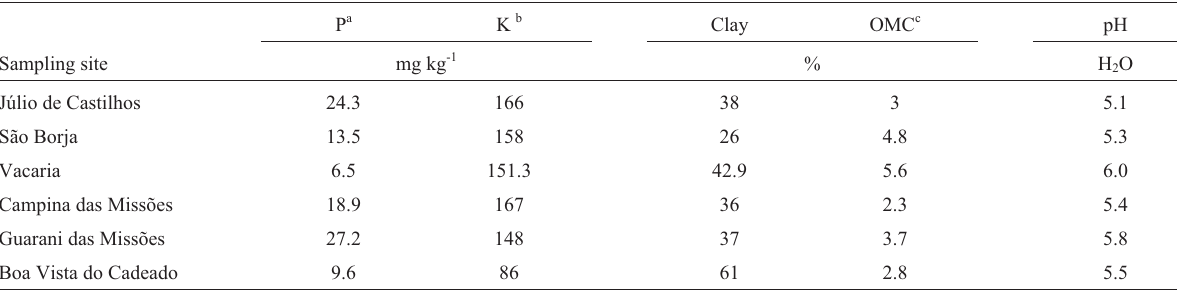
Table 1 - Soil abiotic characteristic at sampling